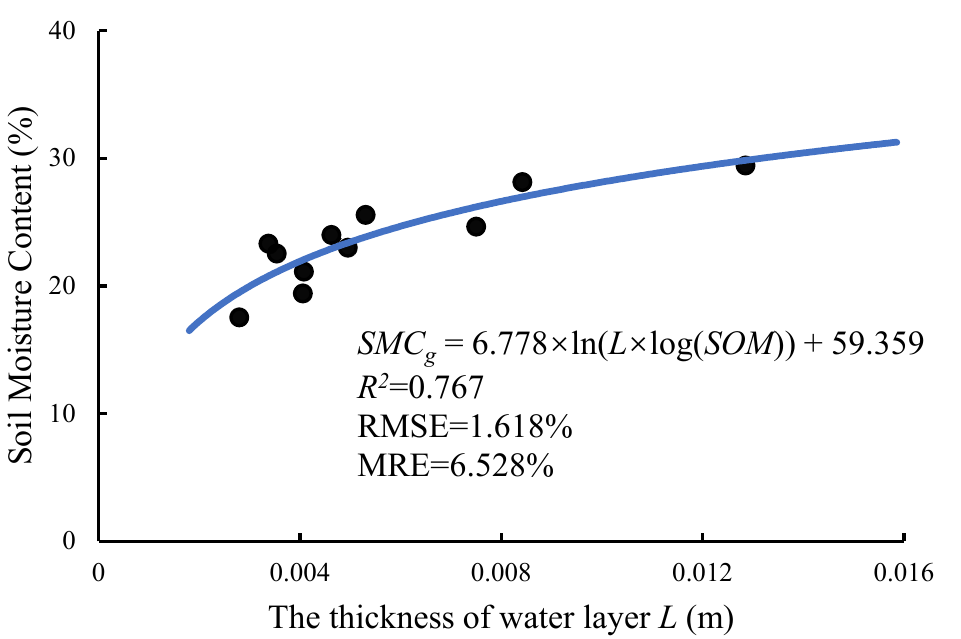
Figure 8. The scattering plot between SMC g and L with the various SOM . To validate the accuracy of the modified model, several evaluation indexes ( R 2 , RMSE , RME ) were employed to compare the performances of two models. In addition, the comparation results are shown in Table 3. Table 3. The comparation of the original and modified